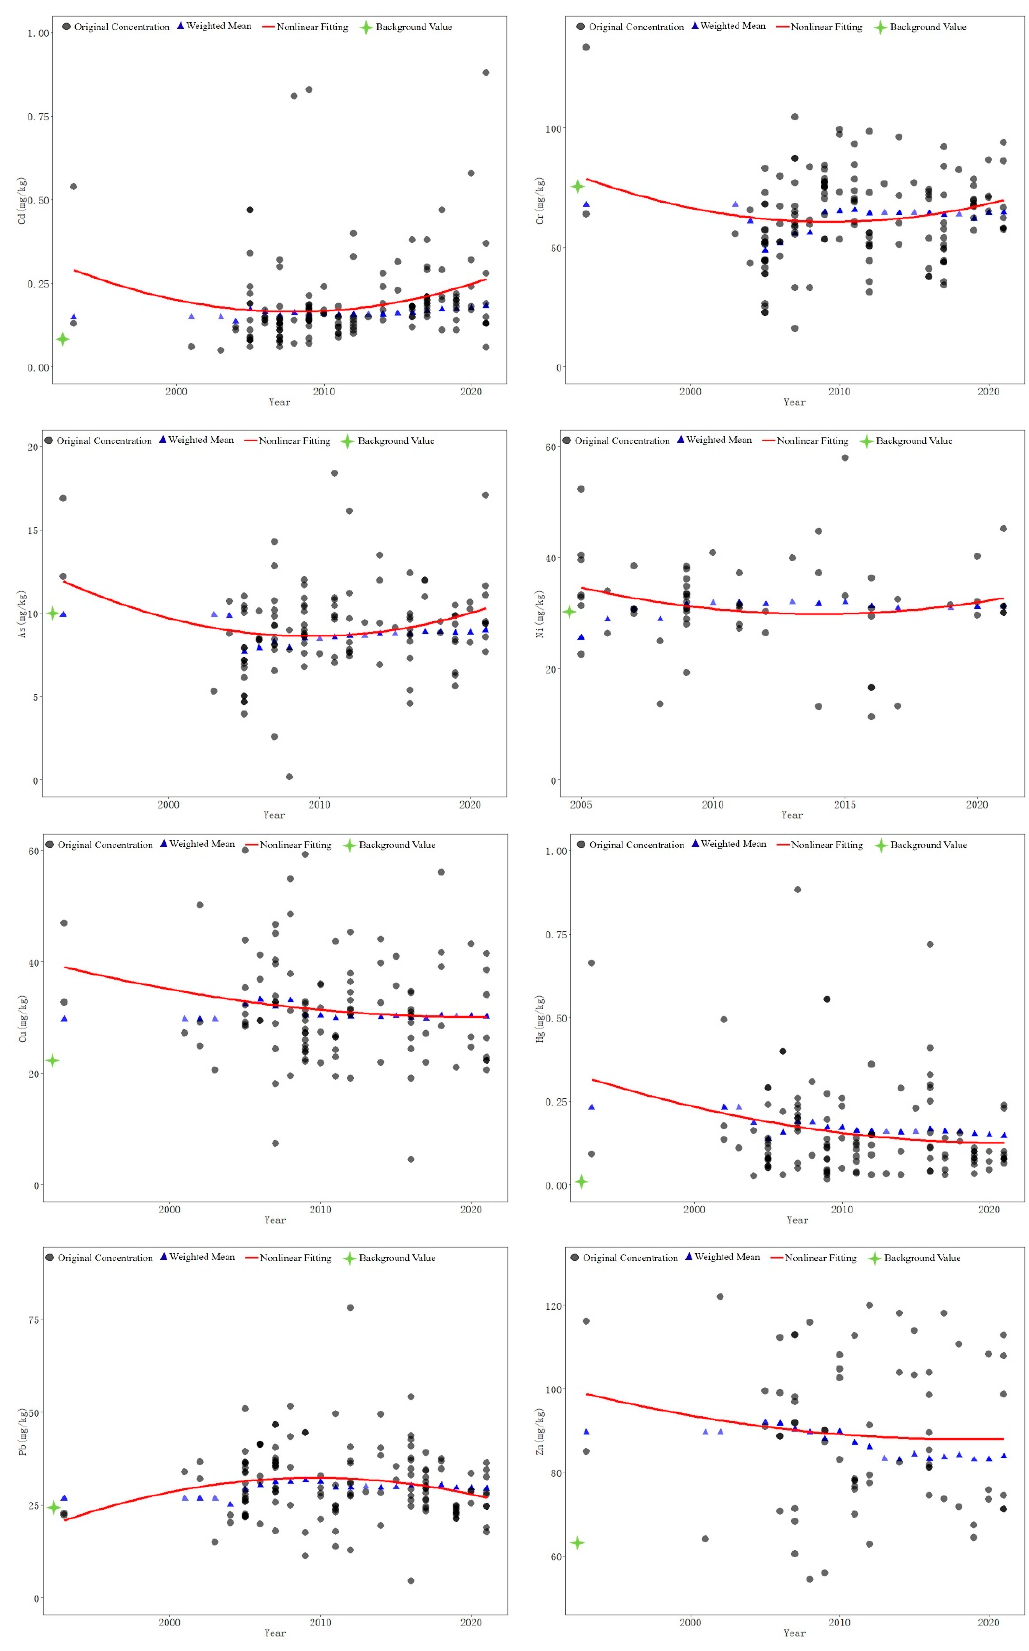
Figure 4. The temporal variation of heavy metal accumulation. The green points represent the agricultural soil background values in Jiangsu.